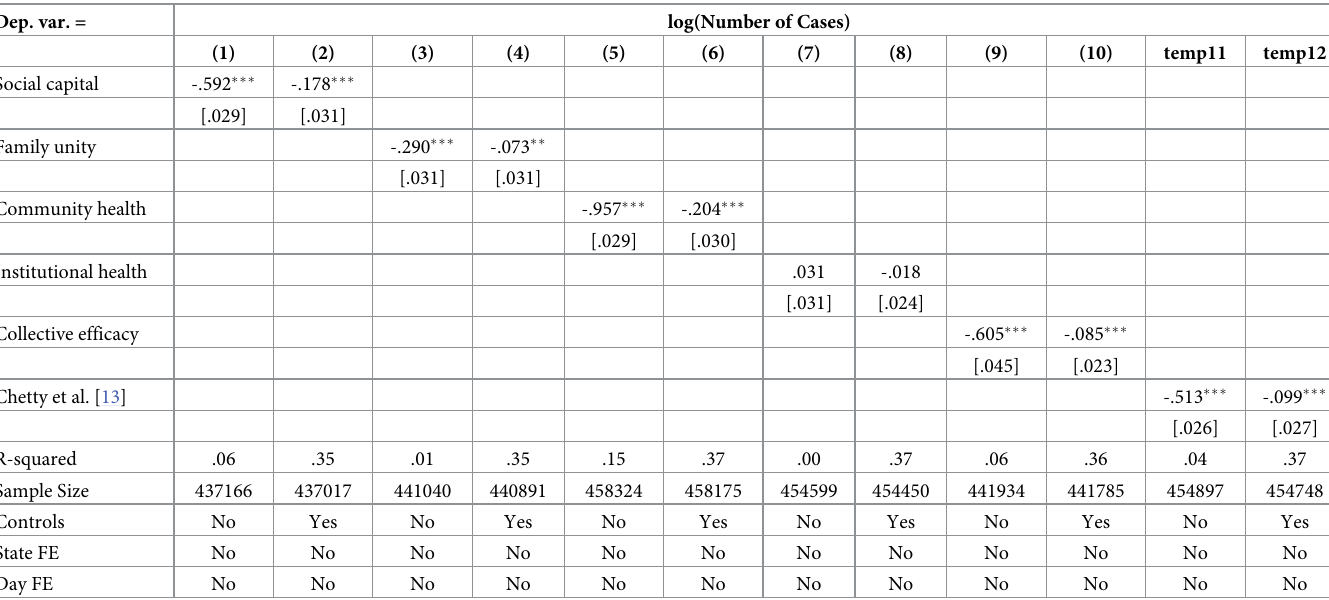
Table 3. Robustness results with alternative social capital measures. Dep. var.